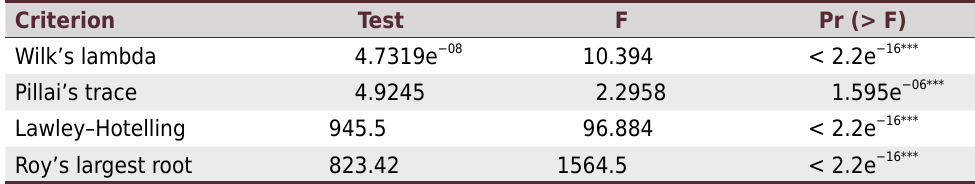
Table 2. Multivariate analysis of variance of soil chemical property data from all treatments